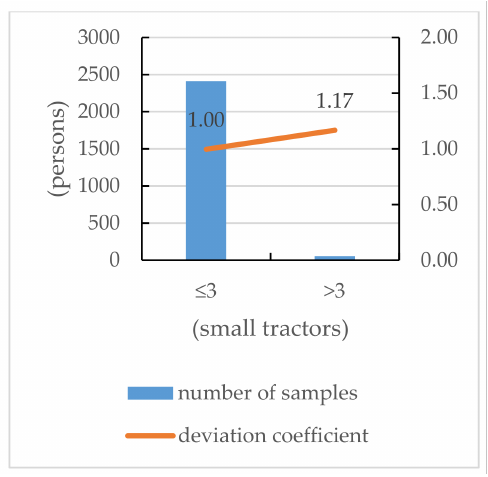
Figure 12. Deviation coefficient of utilization rate of agricultural machinery grouped by the number of small